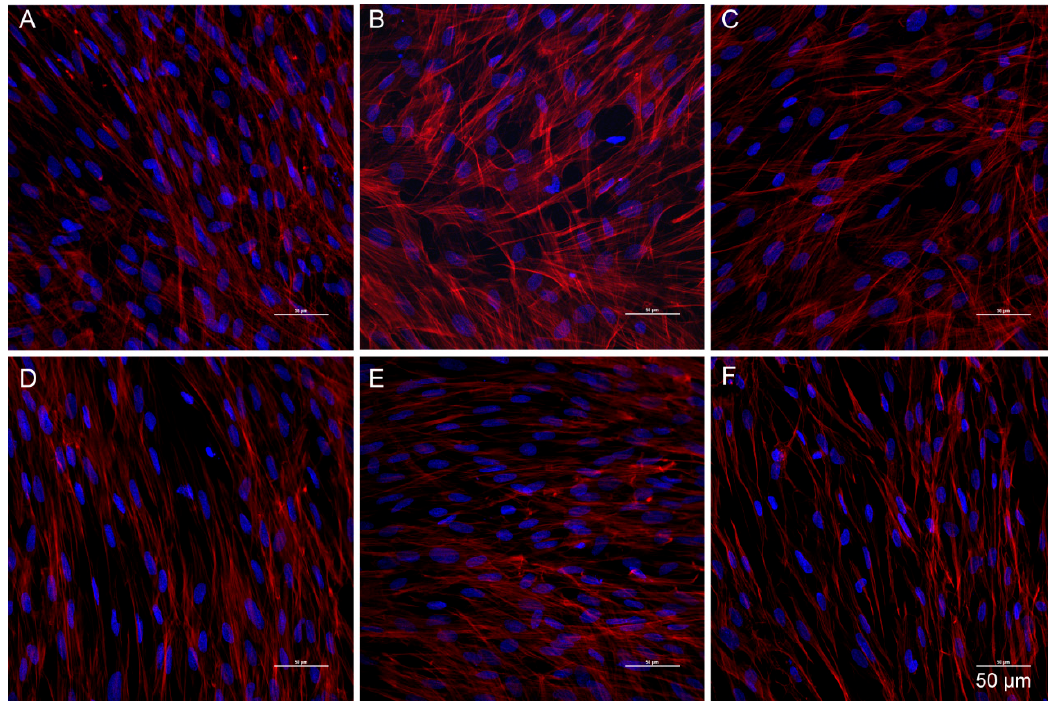
Figure 6. The effects of catalpol on F-actin polymerization induced by LPS detected by immunofluorescence staining. ( A ) normal group; ( B ) model group; ( C ) Fasudil group; ( D ) catalpol 0.3 µ M group; ( E ) catalpol 3.0 µ M group; ( F ) catalpol 30.0 µ M group.